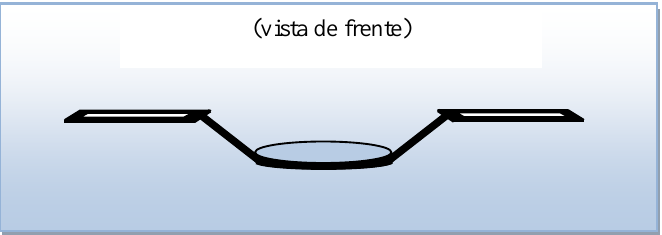
Figura 5. Mostra o KITLAB fora do vaso, desdobrado, sem a sua cuba central.